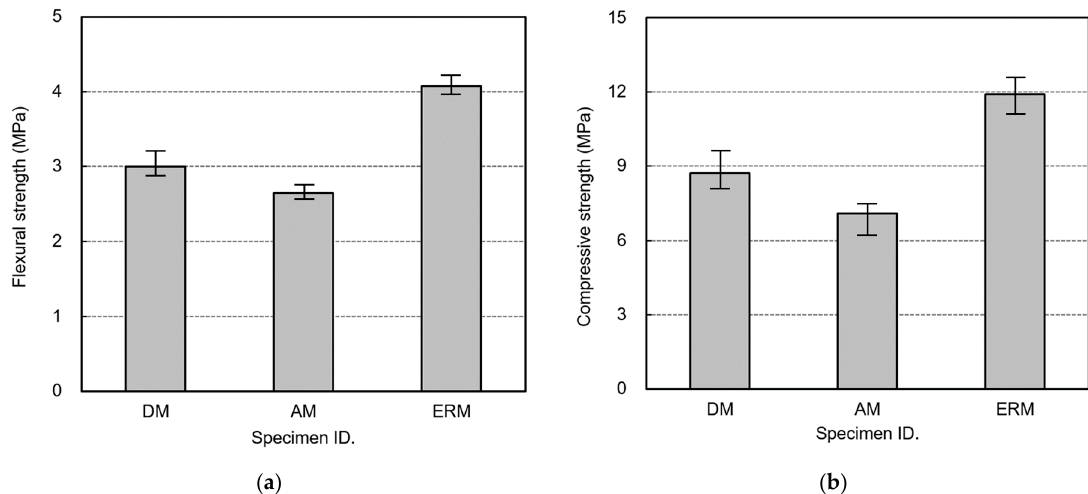
Figure 9. ( a ) Flexural and ( b ) compressive strength based on the mortar type.